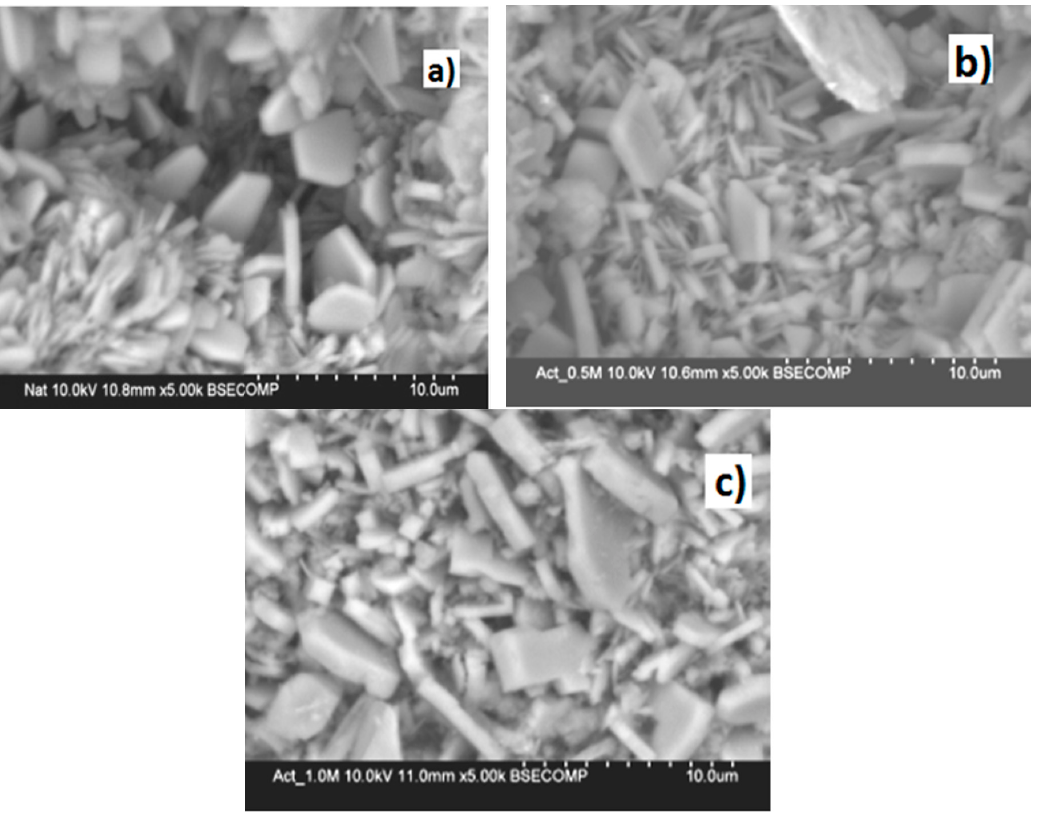
Figure 2. Scanning electron microscopy (SEM) images of ( a ) Nat-CLI; ( b ) HCLI-0.5 and ( c ) HCLI-1.0 M samples. Table 1. Chemical composition (% weight) of non- and acid-modified clinoptilolite-rich tuffs. Sample Si/Al Weight,